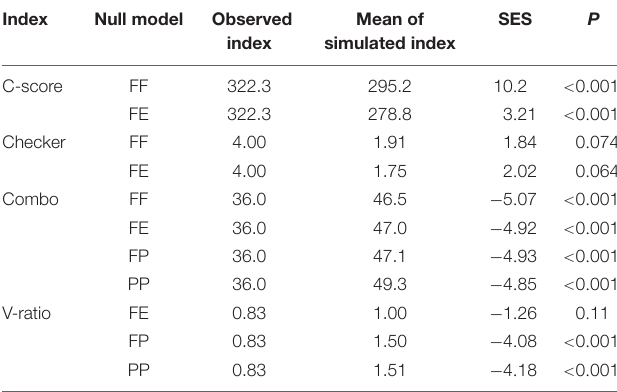
TABLE 5 | The species co-occurrence analysis for all investigated bryophytes in Jinchuan mire, northwest China.